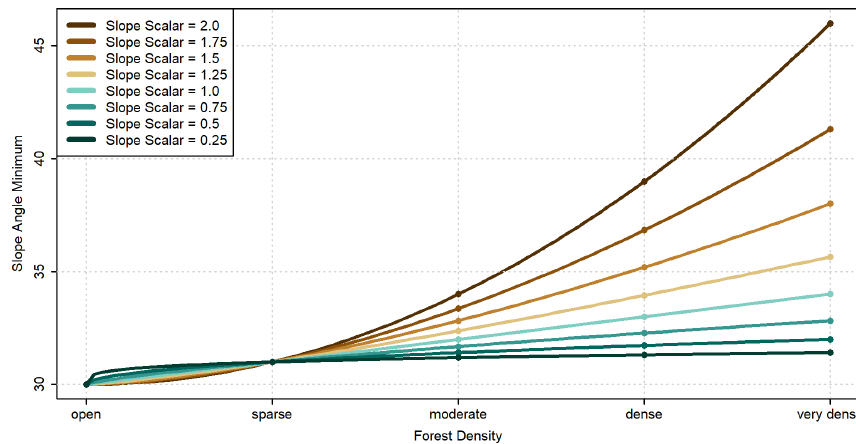
Figure 5. Forest-slope-scalar functions applied to a 30 ◦ minimum slope angle